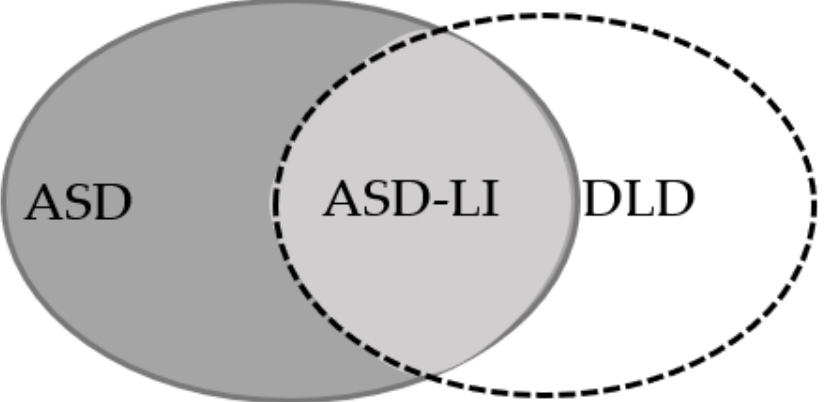
Figure 1. A depiction of the proposed intermediate category ASD-LI, sharing features from both ASD and DLD.